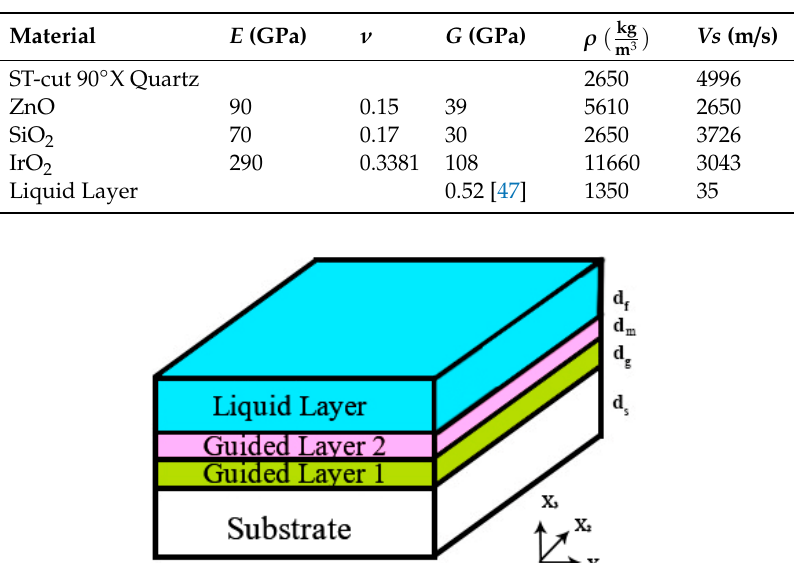
Figure 1. Schematic diagram illustrating the axes and layer parameters for the propagation of shear horizontally polarized acoustic waves in a four-layer system. The first layer is the substrate, and the second layer is the first waveguided layer, the third layer is the second guided layer and the fourth layer is the liquid layer.